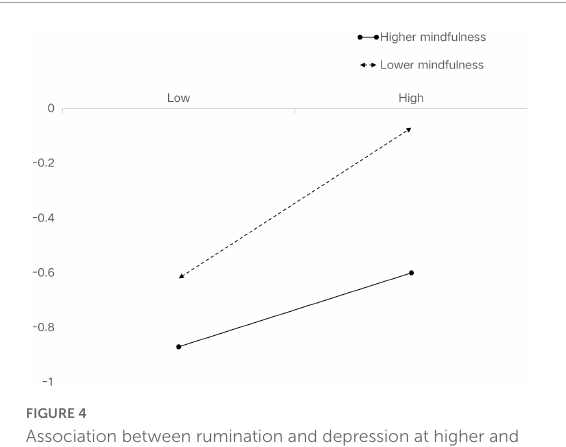
FIGURE4 Association between rumination and depression at higher and lower levels of